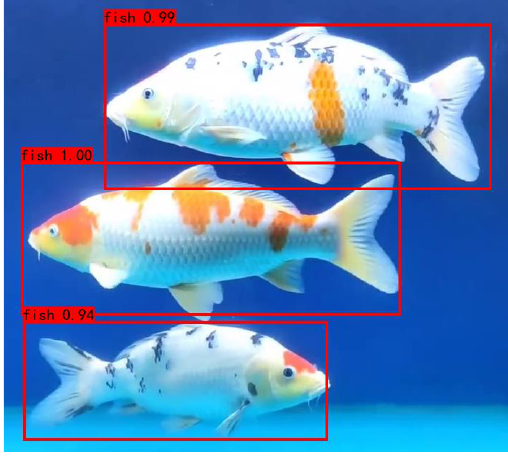
Figure 11. Example of object detection results.